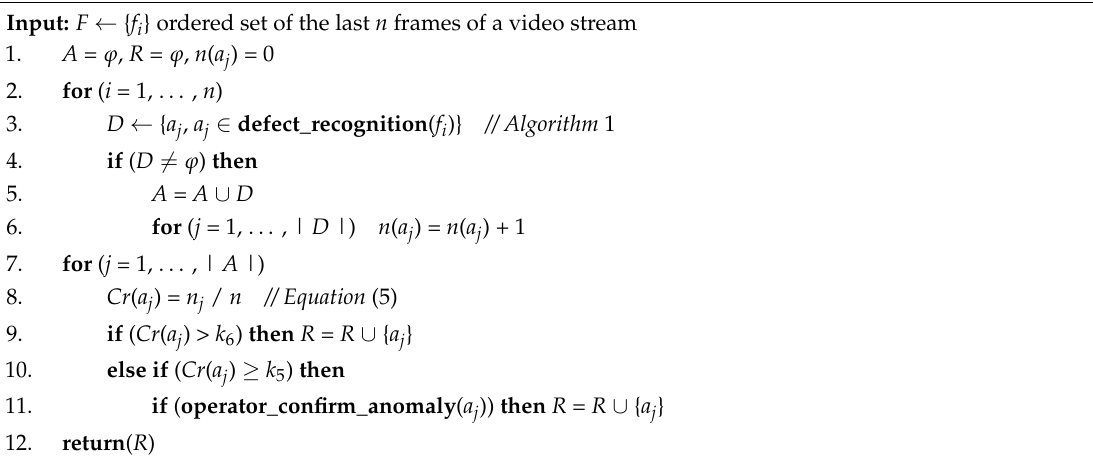
Algorithm 2. Defect recognition in a frame sequence with operator